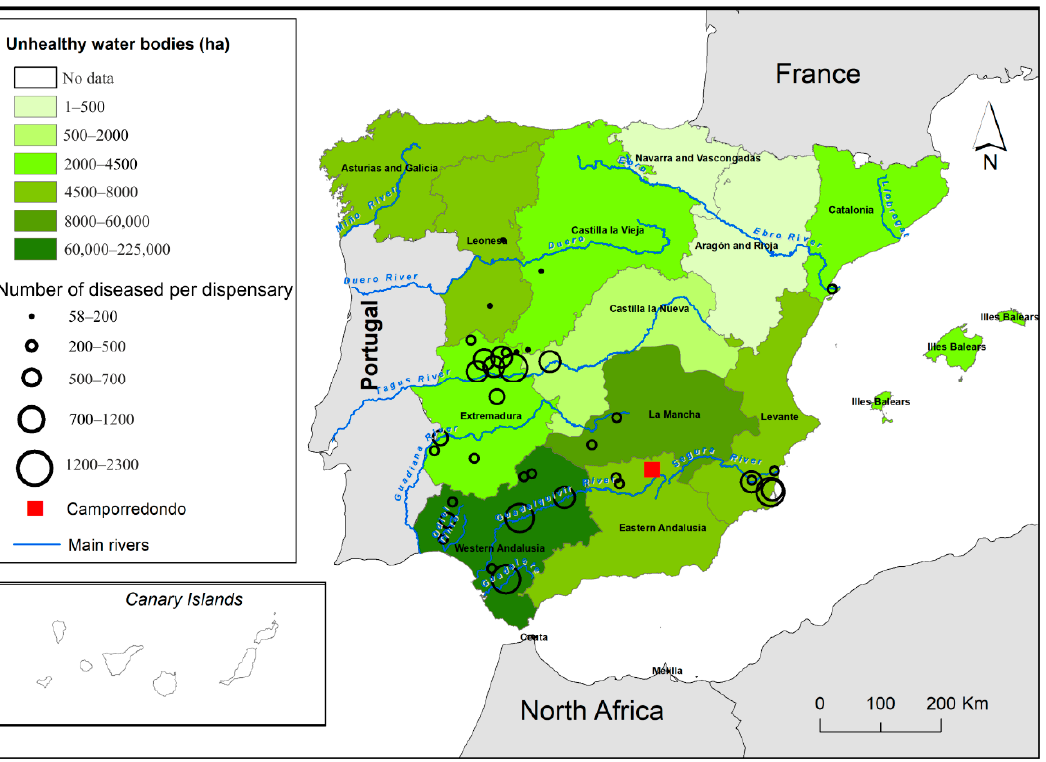
Figure 5. Regional surface occupied by unhealthy water bodies in the early 20th century in Spain and locations and numbers of infected people recorded by Spanish antimalarial dispensaries in 1932.